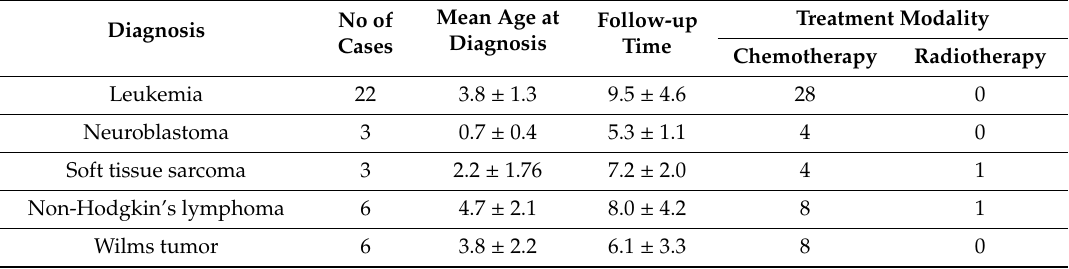
Table 2. General characteristics of the cancer survivors’ group, including the type of cancer, mean age at diagnosis, follow-up time, and treatment modality.